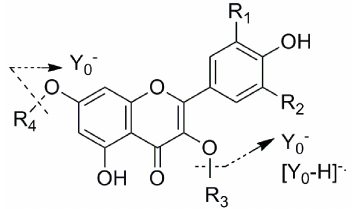
Figure 2. The MS/MS model of flavonoid O-